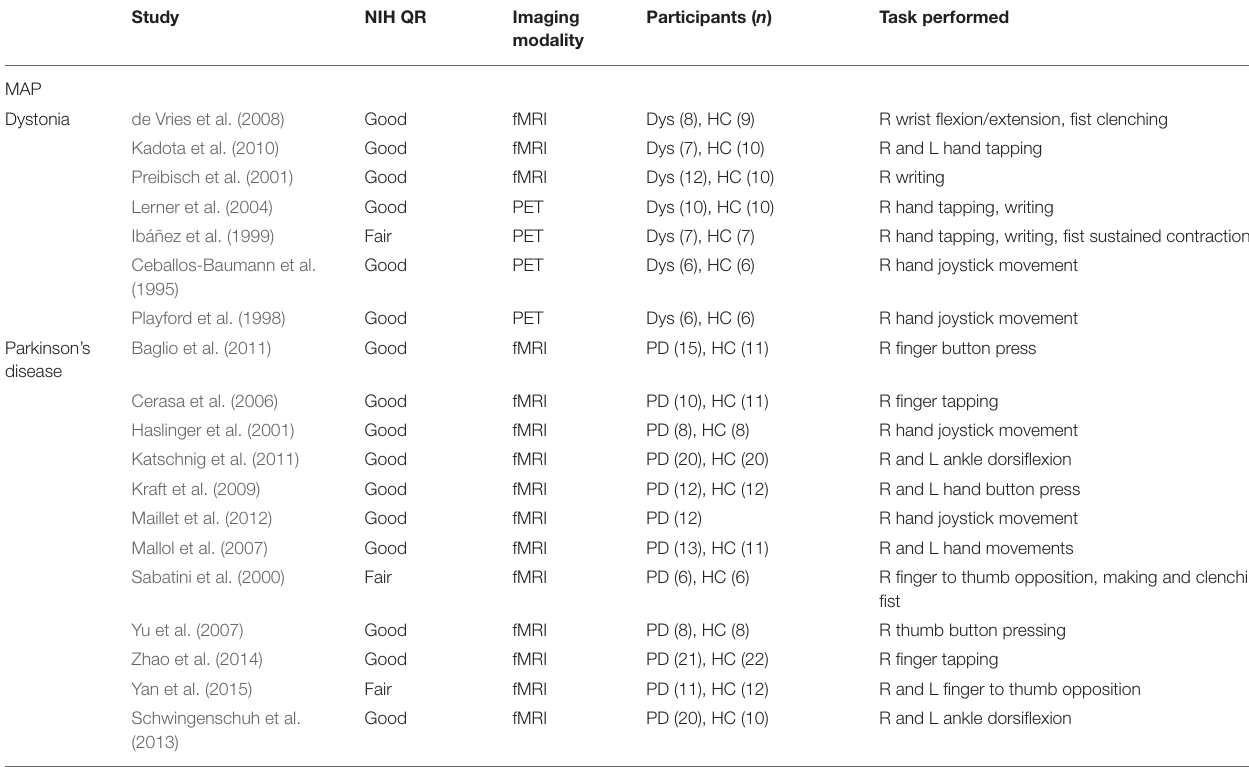
Participants ( n ) Task performed modality